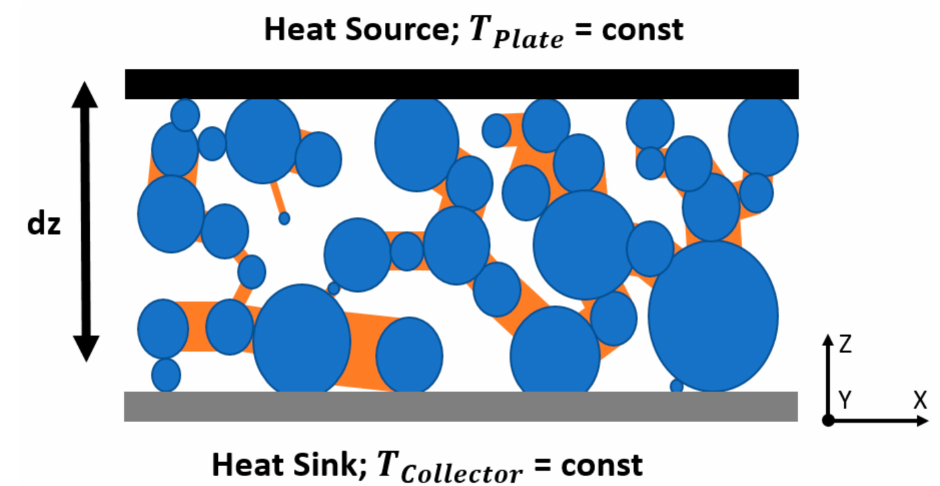
Figure 2. Method to determine the thermal conductivity of the model electrode. Particles shown in blue, carbon black–binder matrix (CBM) in orange, and the heat source and sink in black and grey, respectively.